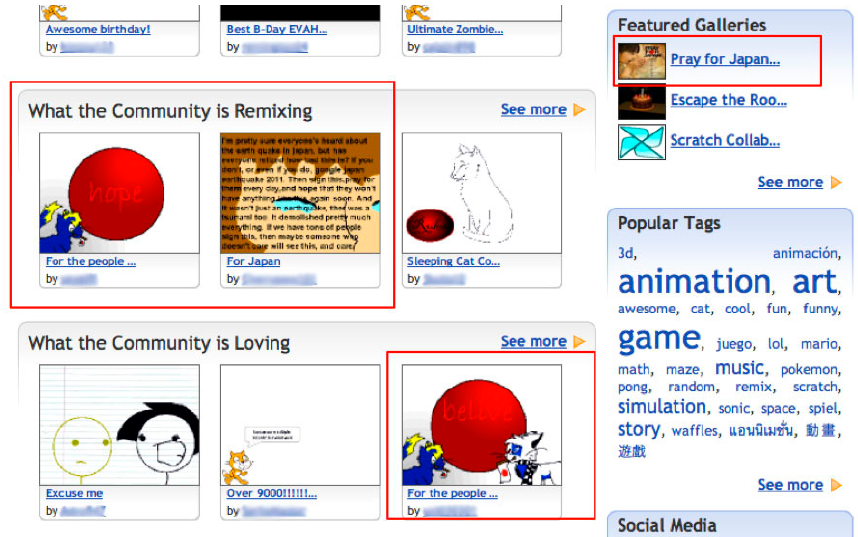
Figure 4. The Scratch homepage soon after the 2011 Japanese earthquake, with projects raising awareness and sharing support appearing under “What the Community is Remixing” along with a featured gallery (top right) called “Pray for Japan” that was collecting these projects.